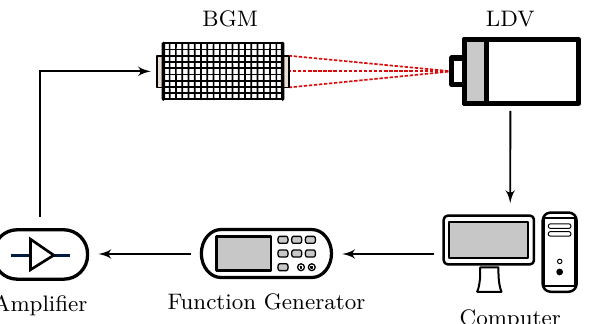
Figure 5. Sketch of the measurement setup with a Laser Doppler Vibrometer (LDV).